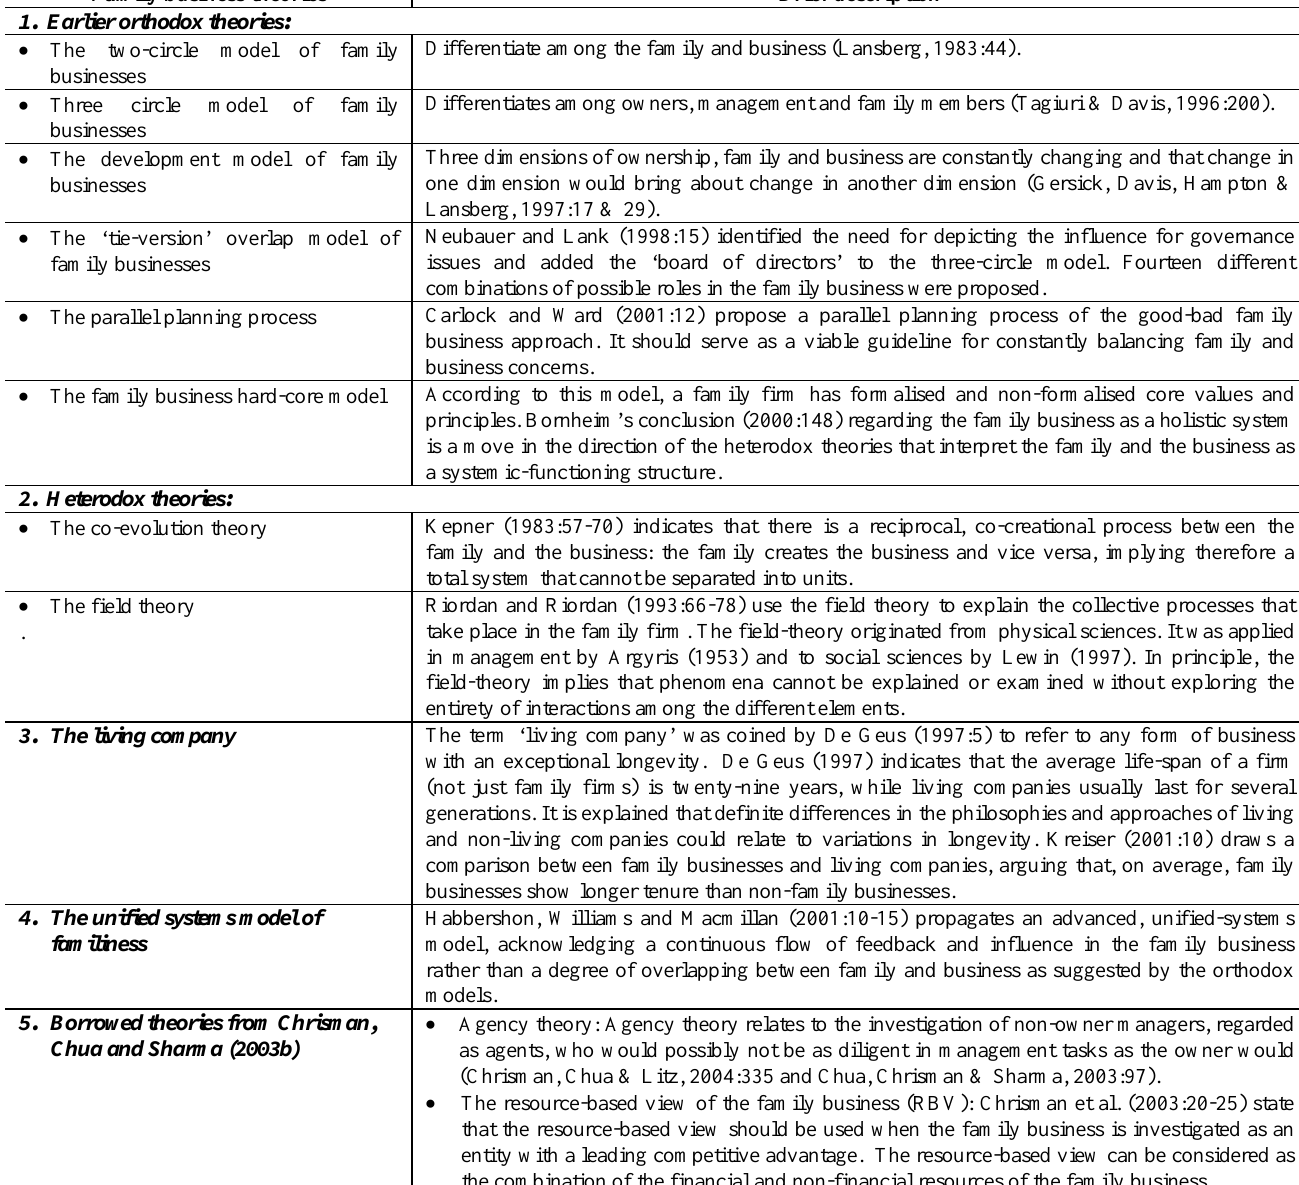
Table 1: Summary of family business theories Family business